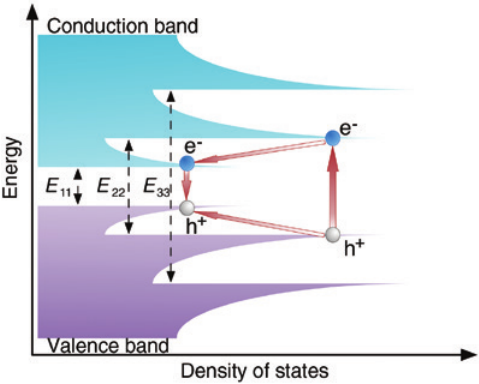
Figure 3: Example of the CNT density of states. On the contrary to the irrepressible chemical reac- tion during covalent functionalization, non-covalent CNT functionalization retains the sp 2 structure of CNTs, preserving their electronic properties [141]. In [142] Nish et al. proposed that both relative orientation of CNT and polymer chain determine the conformation of the polymer around tubes along with electron exchange in the case of m-CNTs. It was observed that π - π interactions between the graphite sheet and the aromatic component amphiphilic molecule include both electrostatic and van der Waals interactions [143]. Hence, polymers containing aromatic moieties appeared to be efficient adsorbents onto the graphite surface [144].